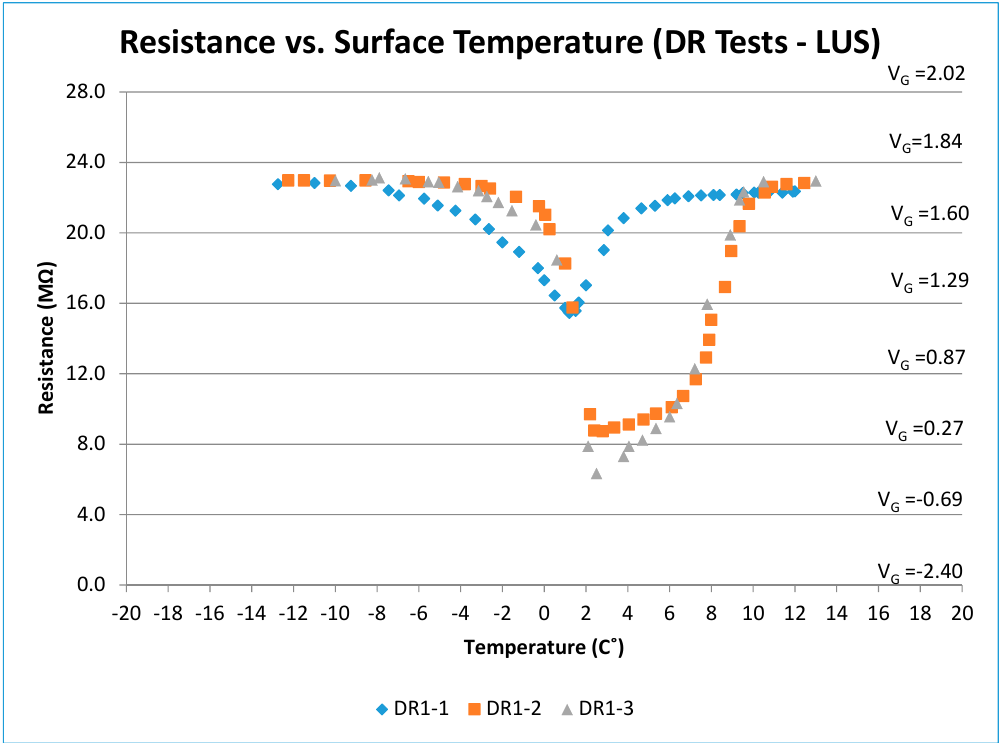
Figure 9. Resistance (and voltage) versus surface temperature for all DR tests (LUS Poles).